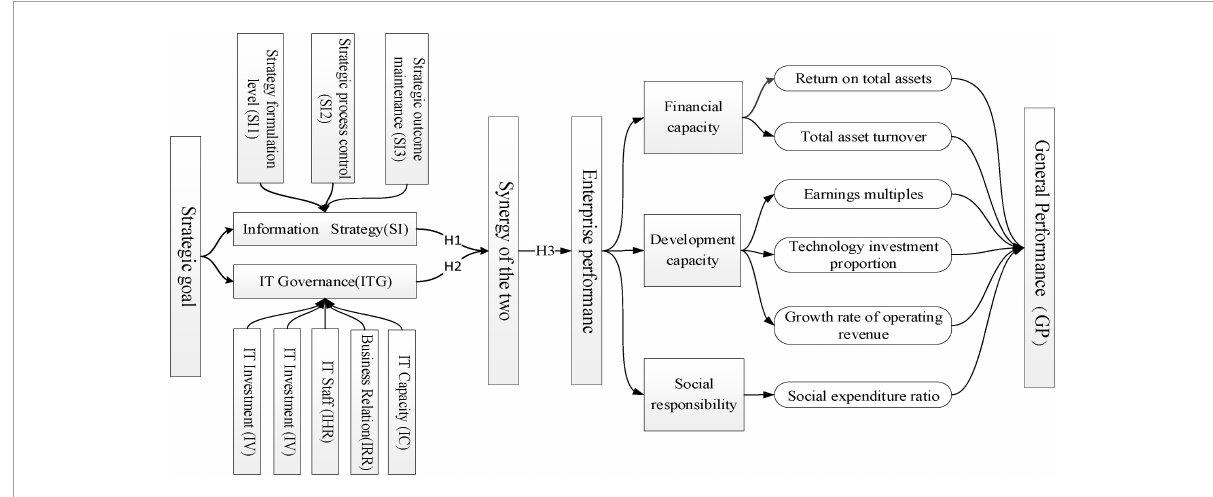
FIGURE1 A research framework.